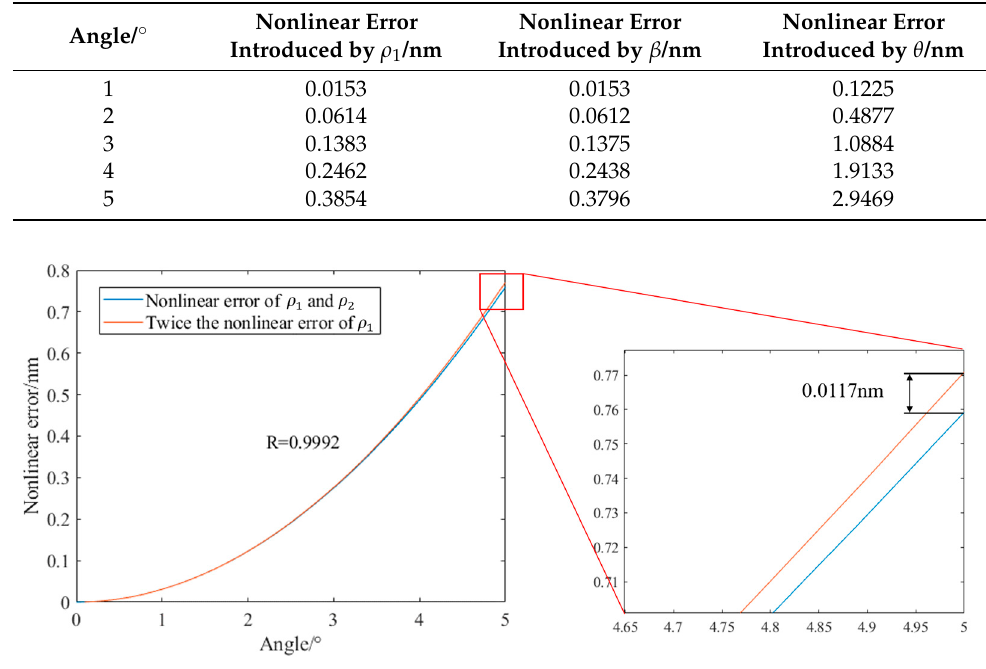
Figure 10. Comparison of the nonlinear errors between one ellipticity and two ellipticities of dual- frequency lasers.